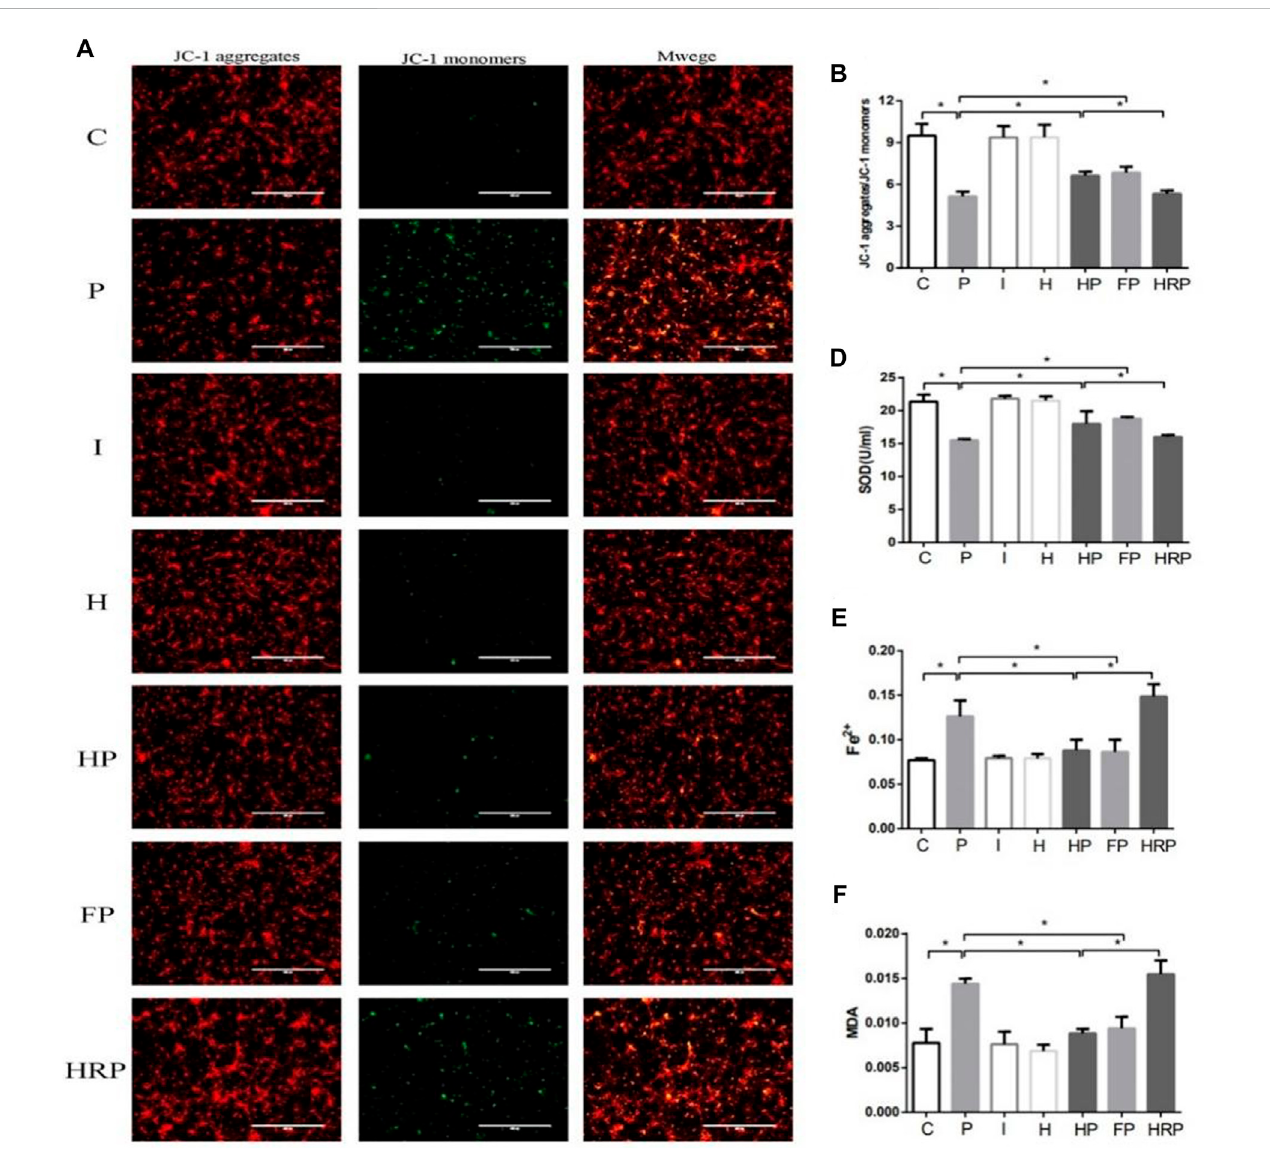
FIGURE 8 Changes in mitochondrial membrane potential, SOD level, Fe2+ level and MDA content in primary hippocampal neurons exposed to propofol with or without hypoxic preconditioning, inhibitor or agonist. (A,B) Fluorescence images of JC-1 aggregates and JC-1 monomers indicating the mitochondrial membrane potential in each group (one-way ANOVA, * p < 0.05). (D – F) The contents of SOD, Fe2+ and MDA in each group (one-way ANOVA, * p <